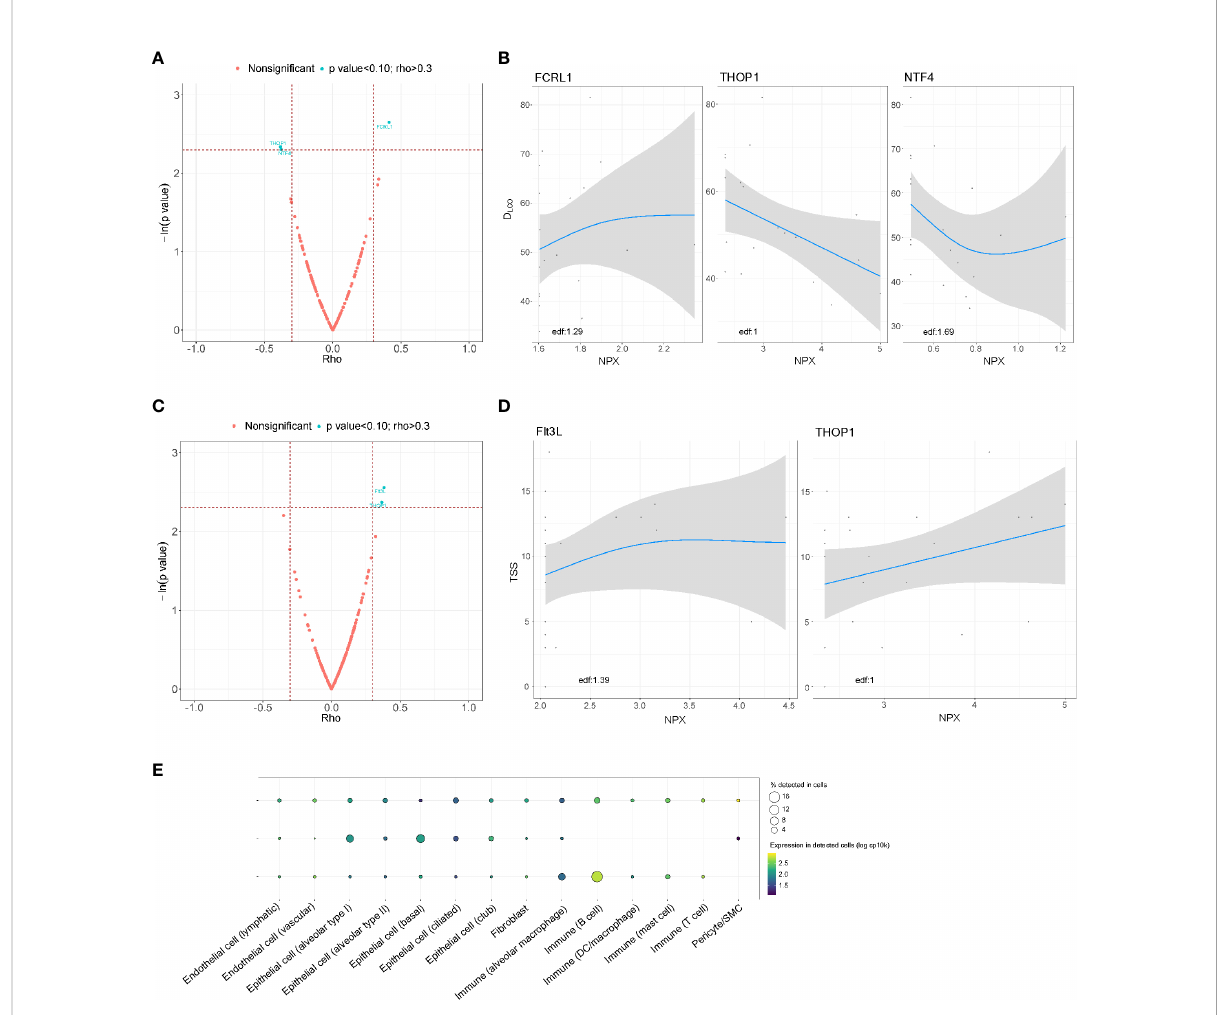
FIGURE 4 Association between the proteomic biopro fi le in bronchial aspirates with diffusion capacity and structural features in survivors of ARDS secondary to SARS-CoV-2 infection. (A) Volcano plot showing the p value versus the rho coef fi cient for each detected protein after comparison of D LCO levels. Each dot represents a protein. Blue dots represent proteins that showed a biologically and clinically relevant correlation with D LCO levels; (B) GAM modeling for D LCO and the levels of each of the selected proteins; (C) Volcano plot showing the p value versus the rho coef fi cient for each detected protein after comparison of TSS levels. Each dot represents a protein. Blue dots represent proteins that showed a biologically and clinically relevant correlation with TSS levels; (D) GAM modeling for TSS and the levels of each of the selected proteins. (E) Cell enrichment analysis based on single-cell RNA-seq data from Genotype-Tissue Expression (GTex). Each row represents a protein, and each column represents a cell type. The color of the point shows the expression levels in detected cells, and the size of the point indicates the percentage of cells in which the expression was detected. Edf: estimated degrees of